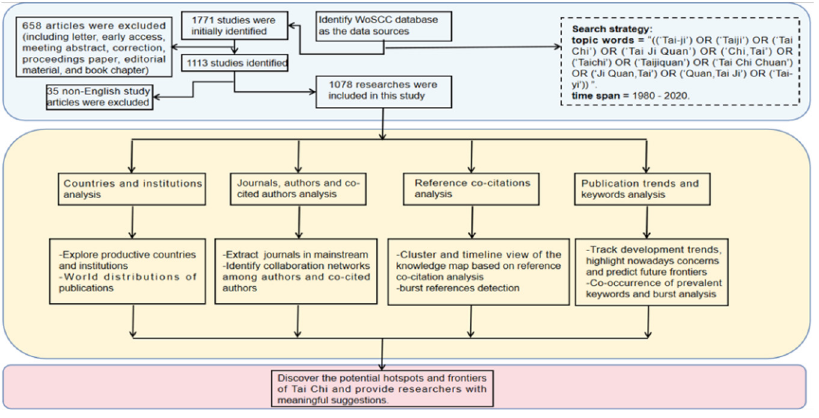
Figure 1. The overview and flowchart of the study design.